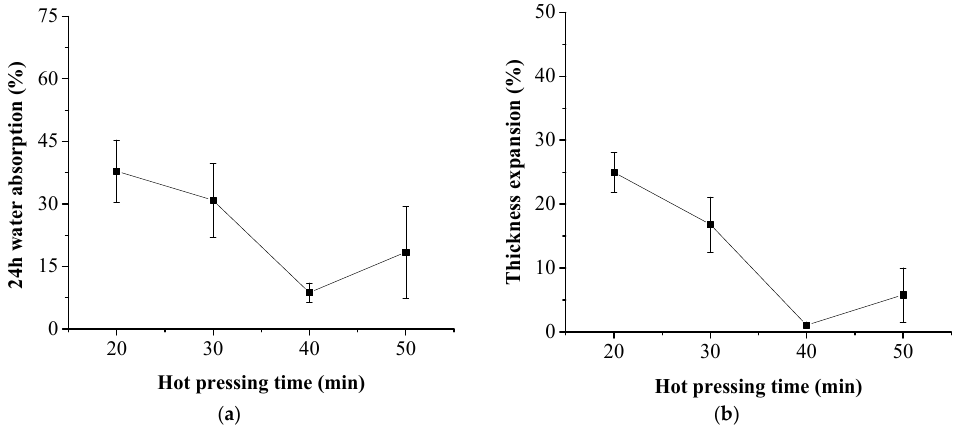
Figure 3. E ff ects of the hot pressing time duration on water absorption and thickness expansion of the composite. ( a ) 24-h water absorption; ( b ) thickness